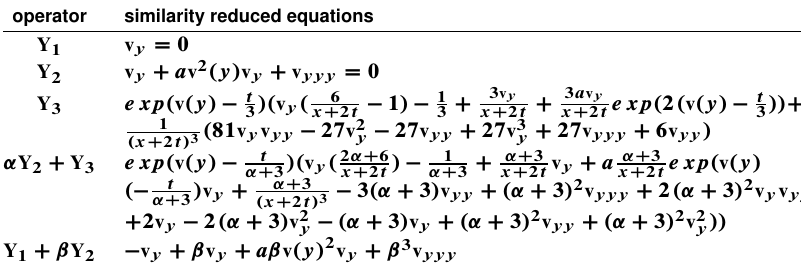
Table 8. Reduced equations (MBBM equation) operator similarity reduced equations